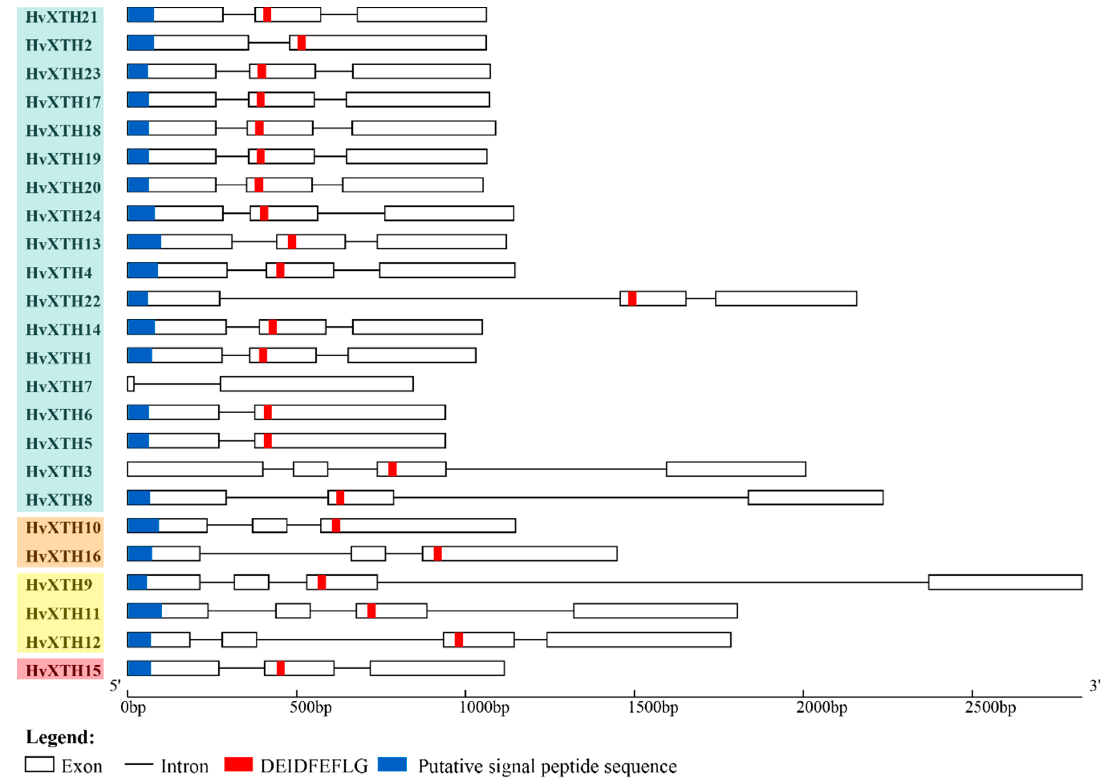
Figure 2. Gene structure and conserved protein domains of XTH genes in barley showing exons, introns, putative signal peptide sequences and motif sequence organization . Group I/II HvXTHs are in light blue, III/A in orange, III/B in yellow and the ancestral group in red. Sequence information is provided in Supplementary Files 3 and 4.